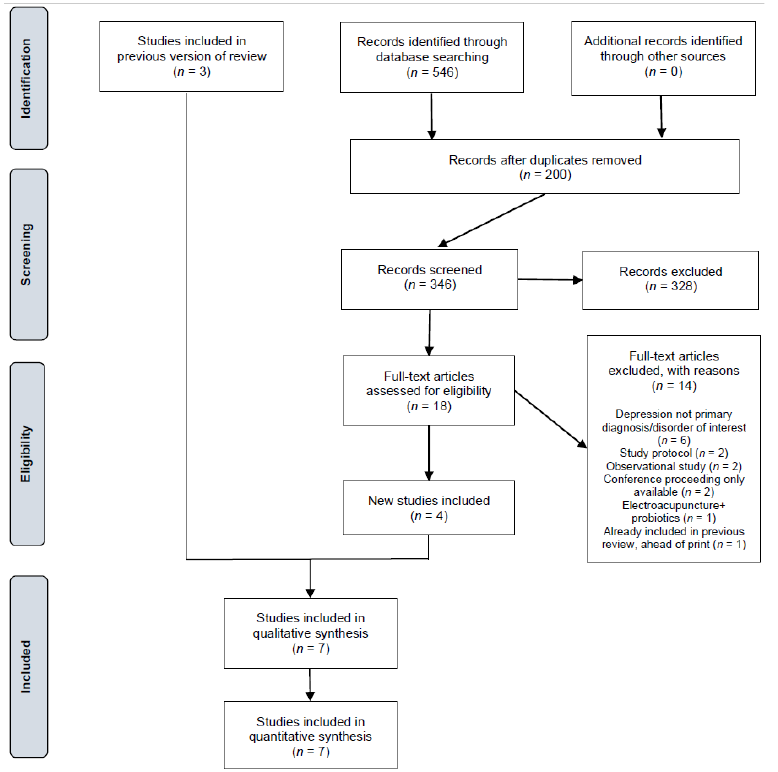
Figure 1. Preferred Reporting Items for Systematic Reviews and Meta-Analyses (PRISMA) study flow diagram for up- dated reviews. Adapted from Stovold et al.